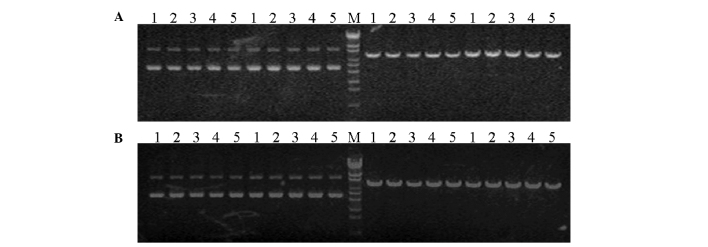
Enzyme digestion identification of the recombinant plasmid. M, DNA marker. (A) The far left 1–5 lanes are the results of the TF-1 PstI digestion; the next 1–5 lanes are the results of the TF-2 PstI digestion; the following 1–5 lanes are the results of the TF-1 BamHI digestion; and the far right 1–5 lanes are the results of the TF-2 BamHI digestion. (B) The far left 1–5 lanes are the results of the TF-3 PstI digestion; the next 1–5 lanes are the results of the TF-4 PstI digestion; the following 1–5 lanes are the results of the TF-3 BamHI digestion; and the far right 1–5 lanes are the results of the TF-4 BamHI digestion. TF, tissue factor.